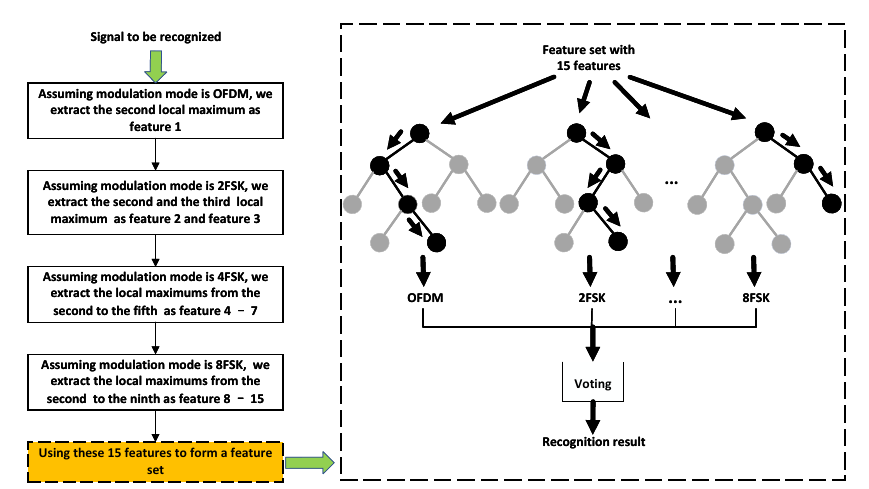
Figure 7. The training process of the RF classifier.